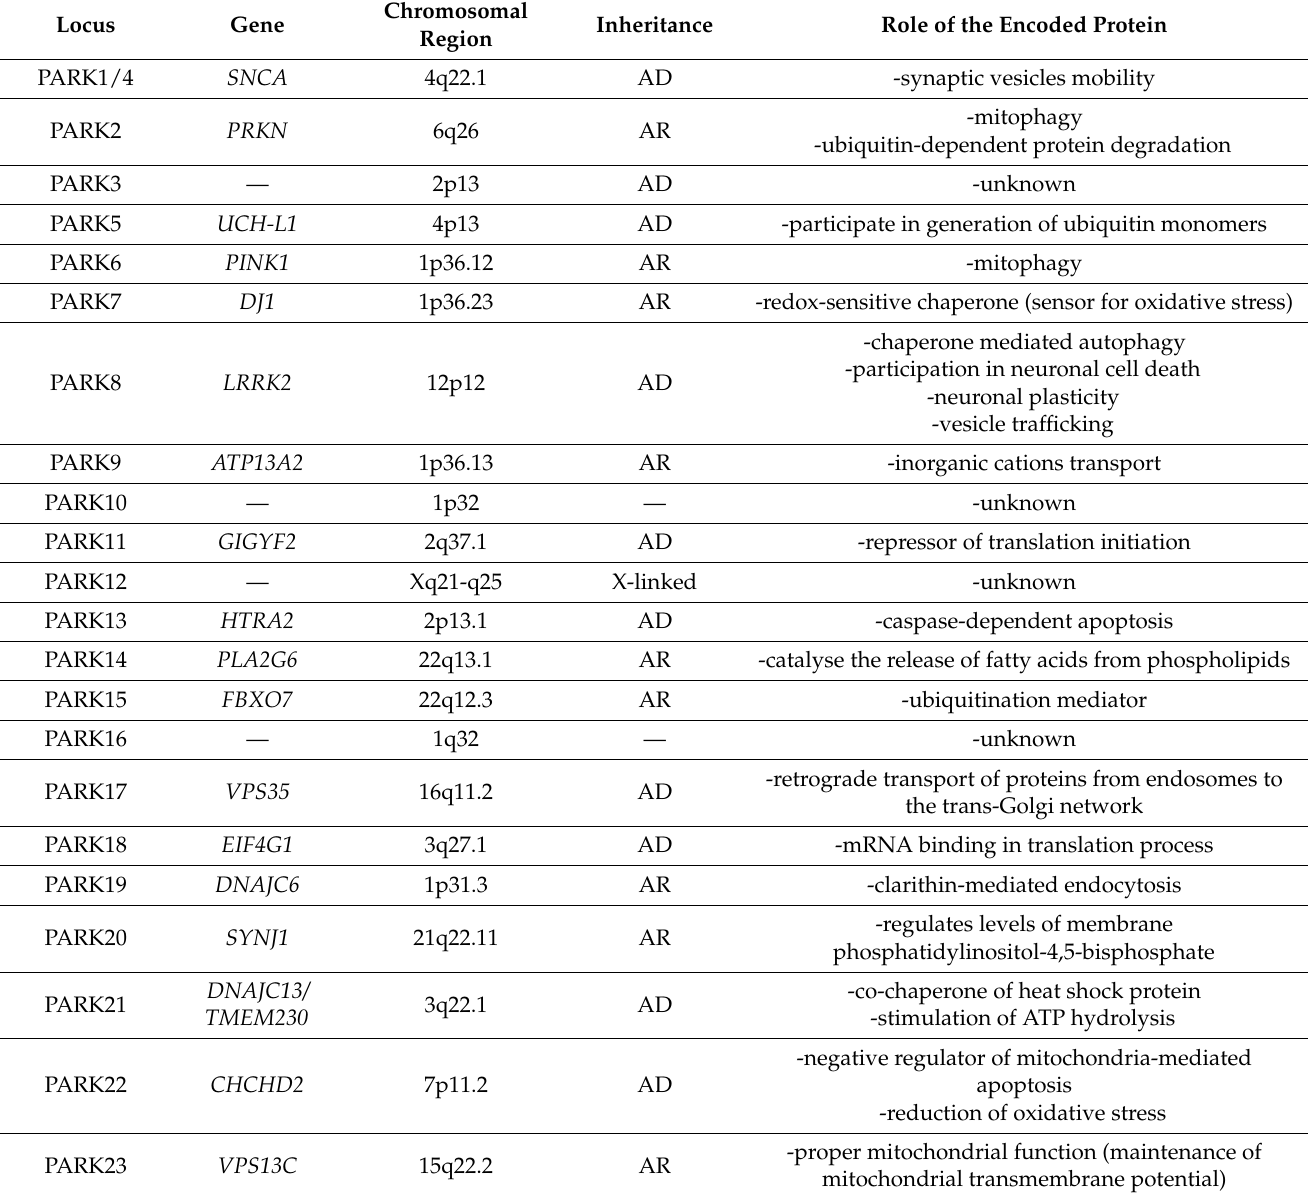
Table 2. Genes responsible for the monogenic forms of PD